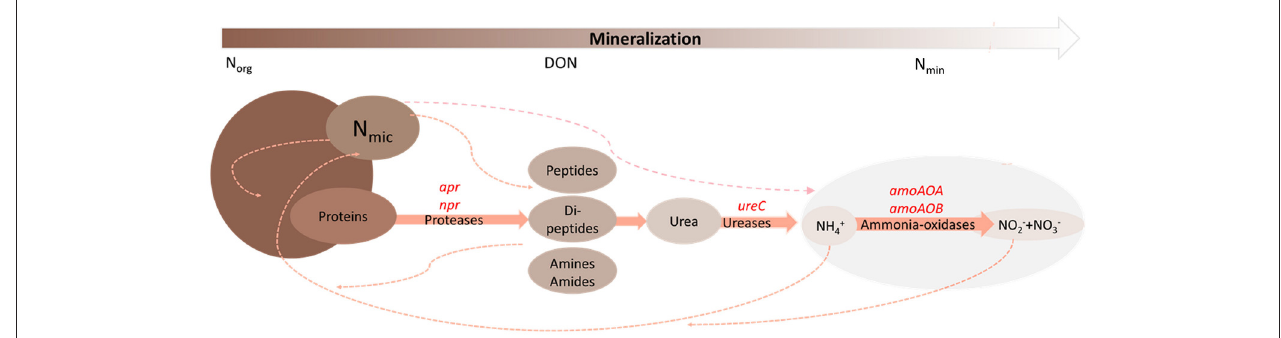
FIGURE 1 | Simplified scheme of soil microbial mediated nitrogen mineralization. Organic nitrogen (N org ) is mineralized into mineral nitrogen (N min ) via different steps and enzymes. Functional genes encoding for the respective enzymes are highlighted in red and abbreviated as alkaline metallopeptidase ( apr ), neutral metallopeptidase ( npr ), urease ( ureC ), bacterial ammonia-oxidase ( amoAOB ), archaeal ammonia-oxidase ( amoAOA ). Nitrogen losses like leaching or N 2 O production are not considered in this scheme. Microbial bound nitrogen (N mic ), dissolved organic nitrogen (DON) and mineral nitrogen (N min = NO − 2 + NO − 3 + NH + 4 ) represent the labile N pool (N labile